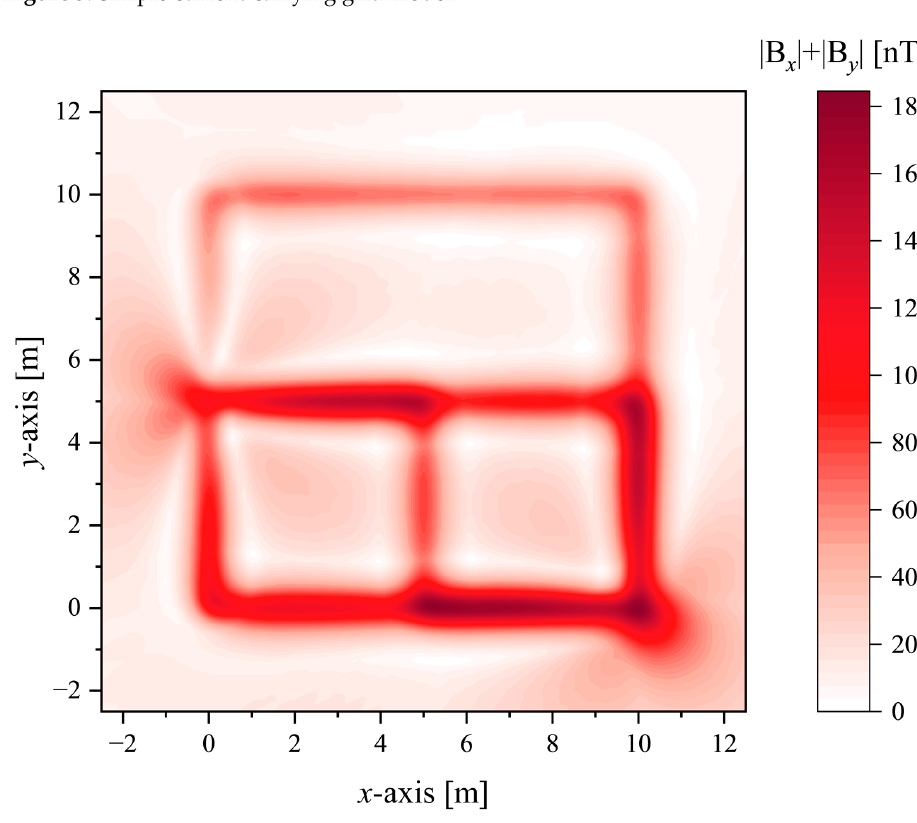
Figure 4. The distribution of the magnetic fl ux density mode at the plane h = 0.5 m.